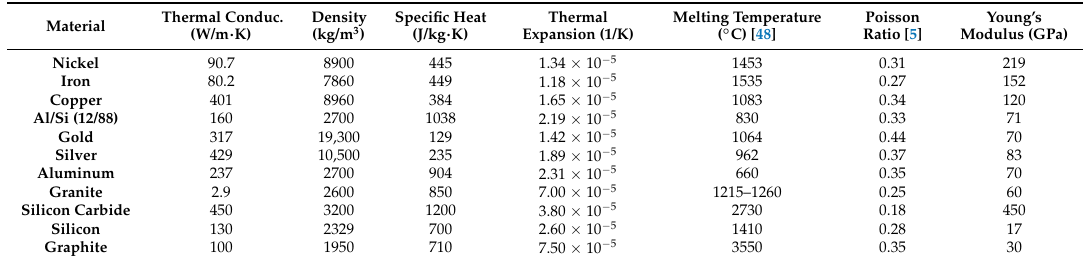
Table 1. Solid thermo-physical properties of shell material candidates